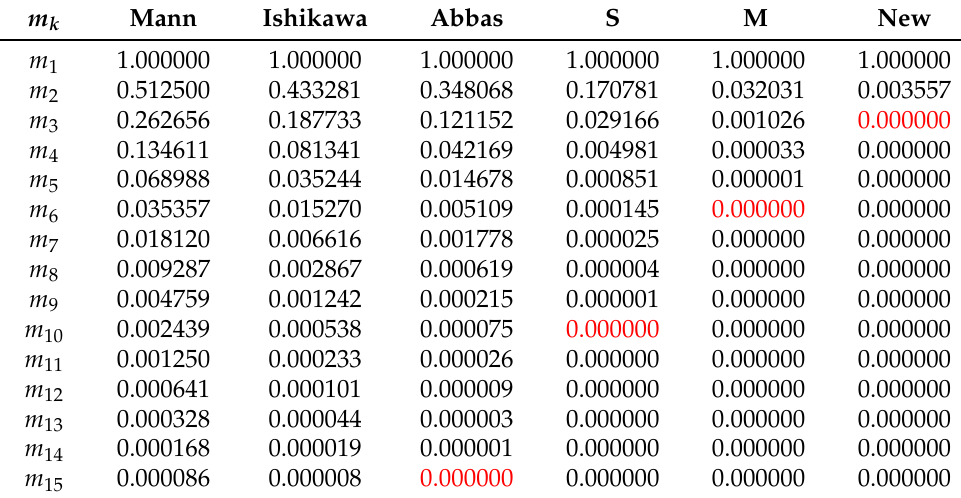
Table 1. Convergence behavior of various iterative algorithms.